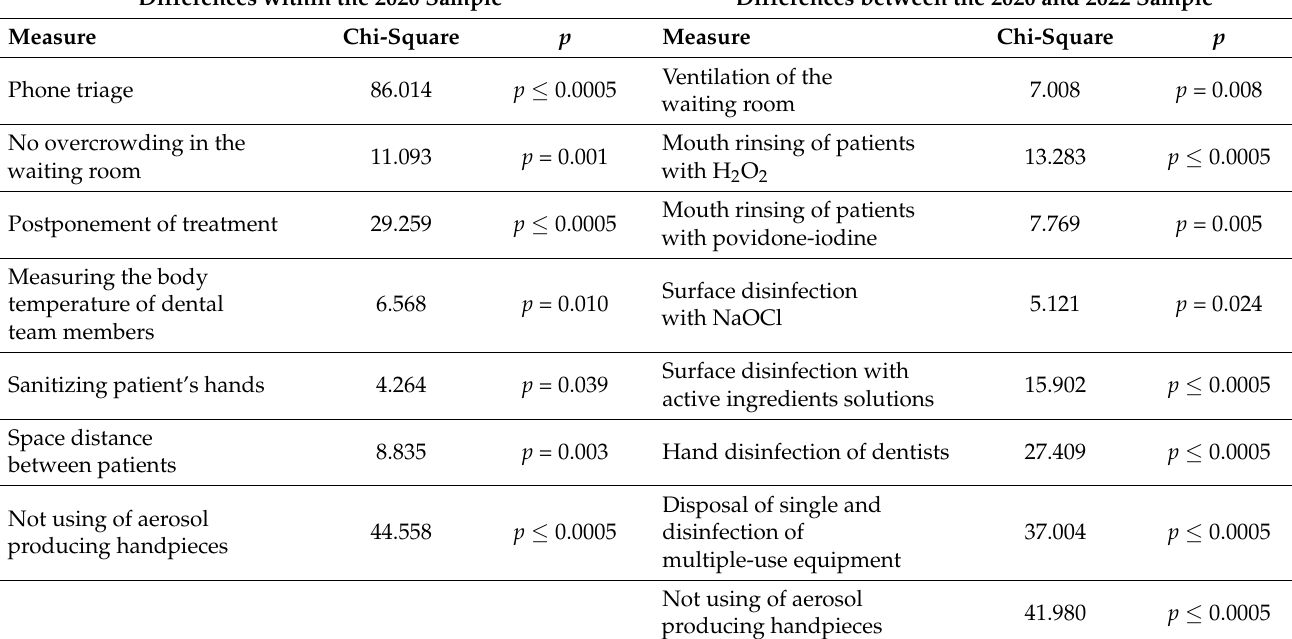
Table 5. Differences in COVID-19 patient management measures within the 2020 sample and between the 2020 and 2022